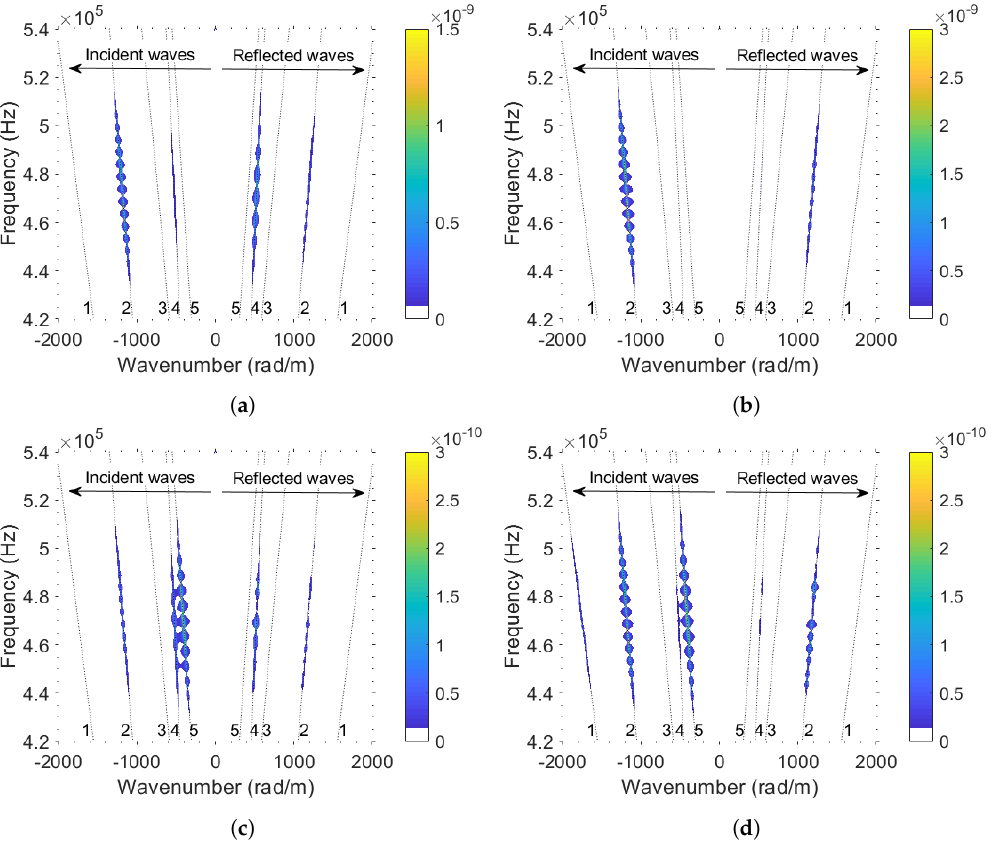
Figure 5. Frequency–wavenumber spectra of wave modes propagating in the aluminium-CFRP plate and reflecting from the 1mm crack in the aluminium: ( a ) for in-plane and ( b ) out-of-plane components while exciting Mode 2 at 475kHz, and ( c ) for in-plane and ( d ) out-of-plane components while exciting Mode 5 at